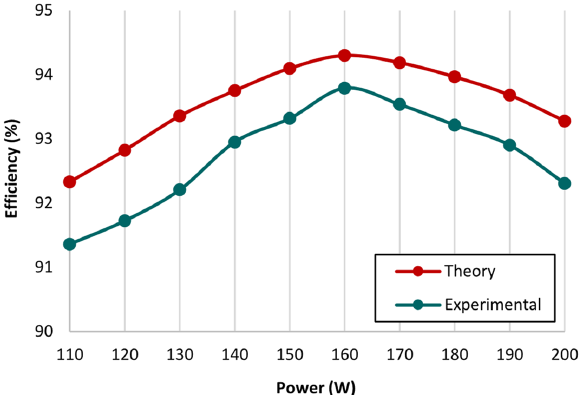
Figure 10. Output power versus efficiency comparison related to theoretical and experimental re- sults.